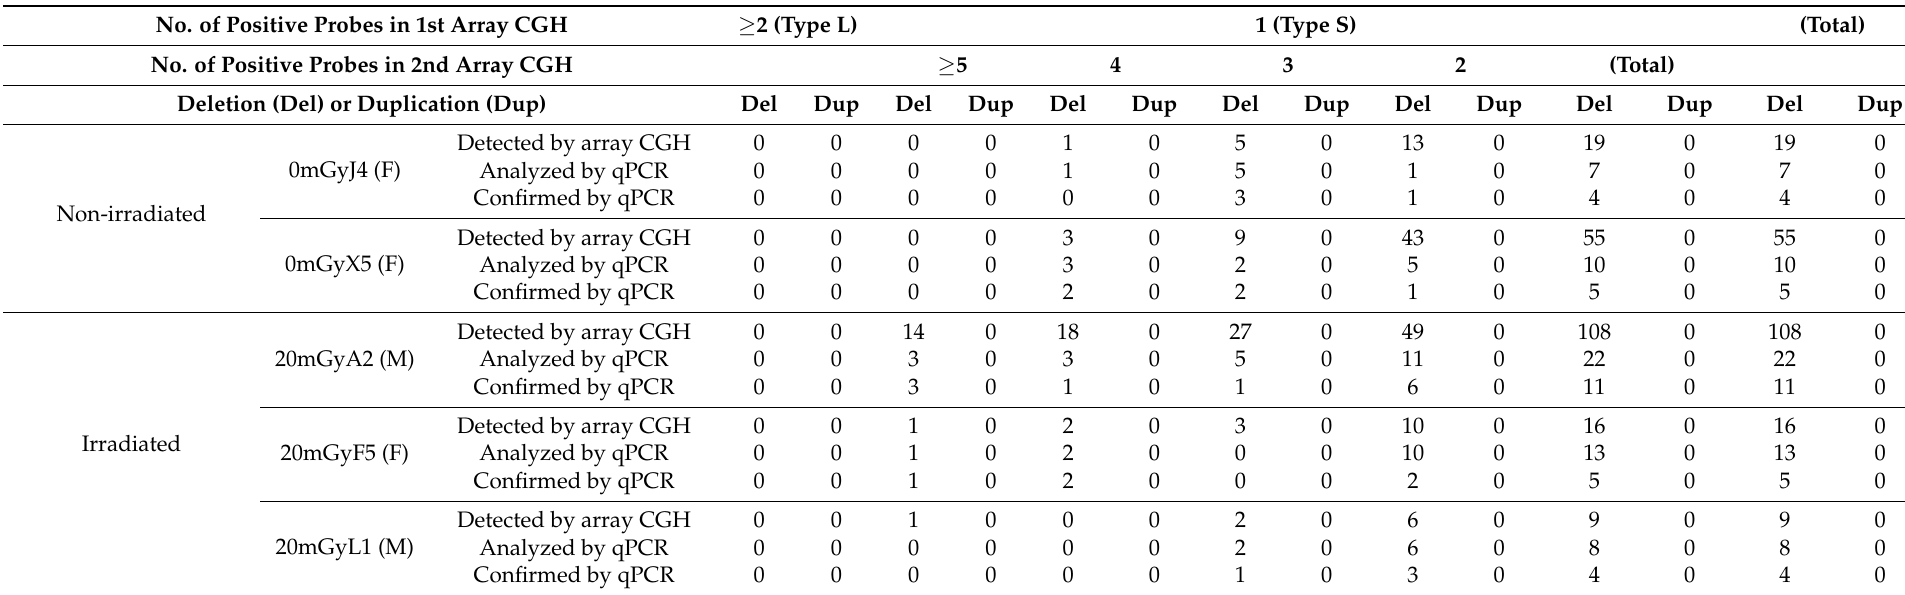
Table 4. Number of the F1 mice with confirmed de novo